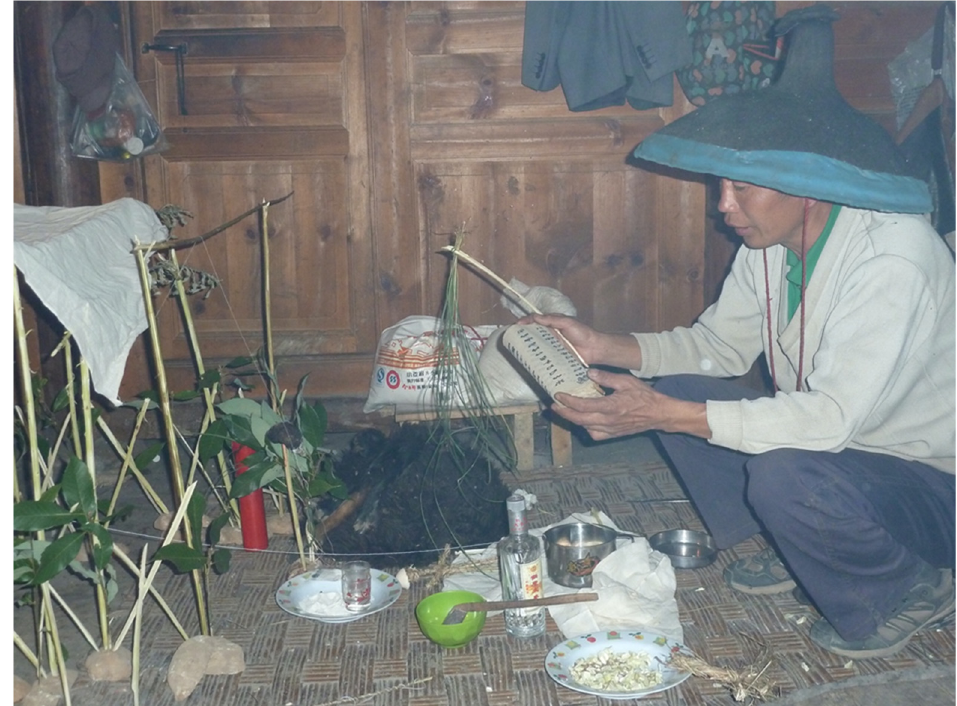
Figure 6. A Nuosu priest chants scriptures in front of an effigy of the roads that ghosts should take when leaving the home during a ritual exorcism in Niplat, 2011. Photograph by the author.